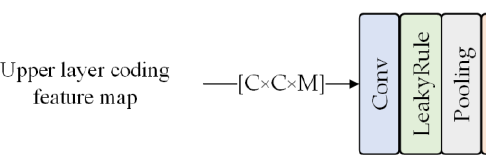
Figure 3. Structure of the encoding module.